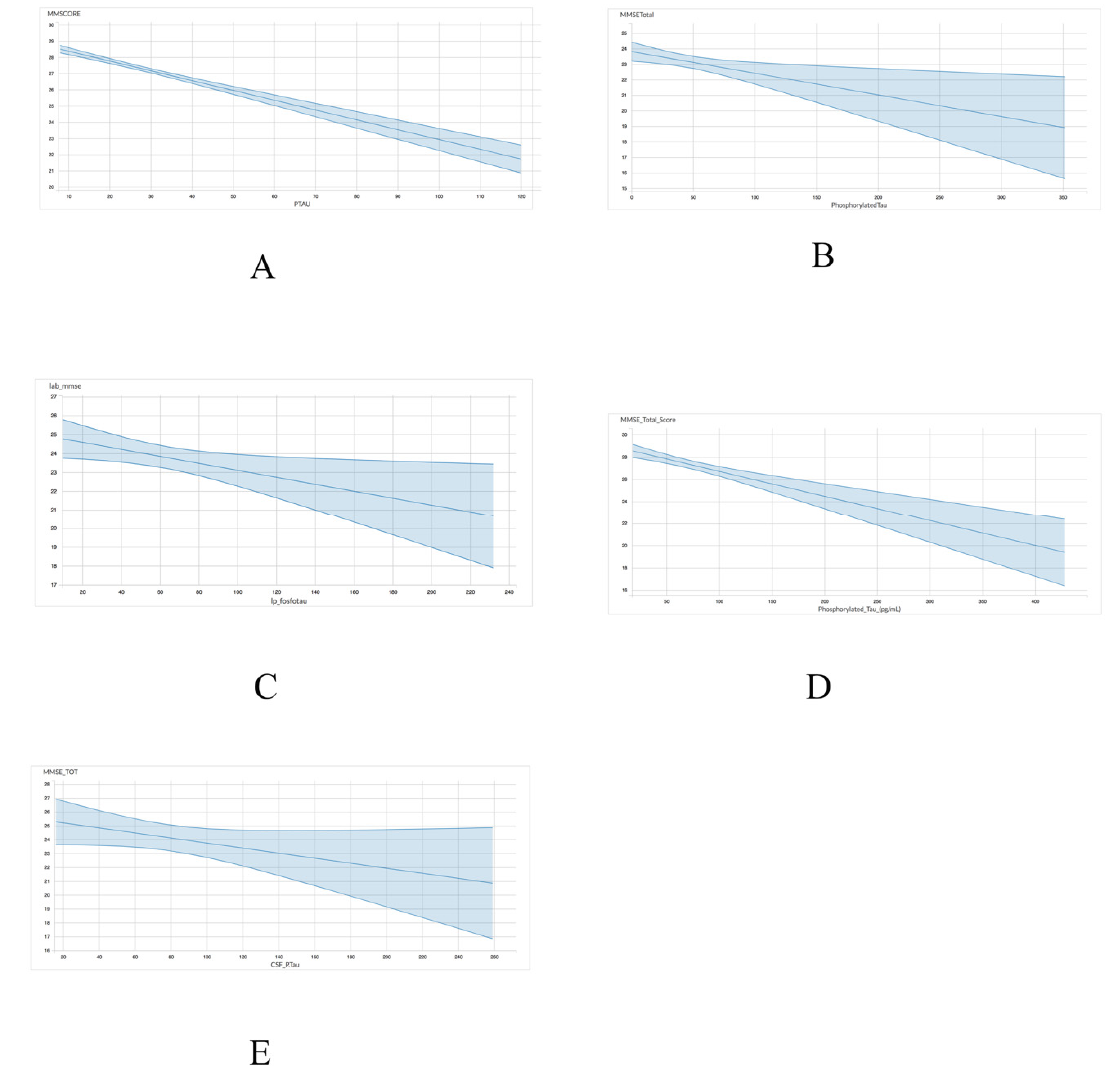
Figure 2. Graphical representation for the correlations between p-tau and MMSE in 5 datasets from GAAIN database. ( A ) ANDI, ( B ) INDD, ( C ) CBAS, ( D ) DESCRIPA, and ( E ) EPINETTE.